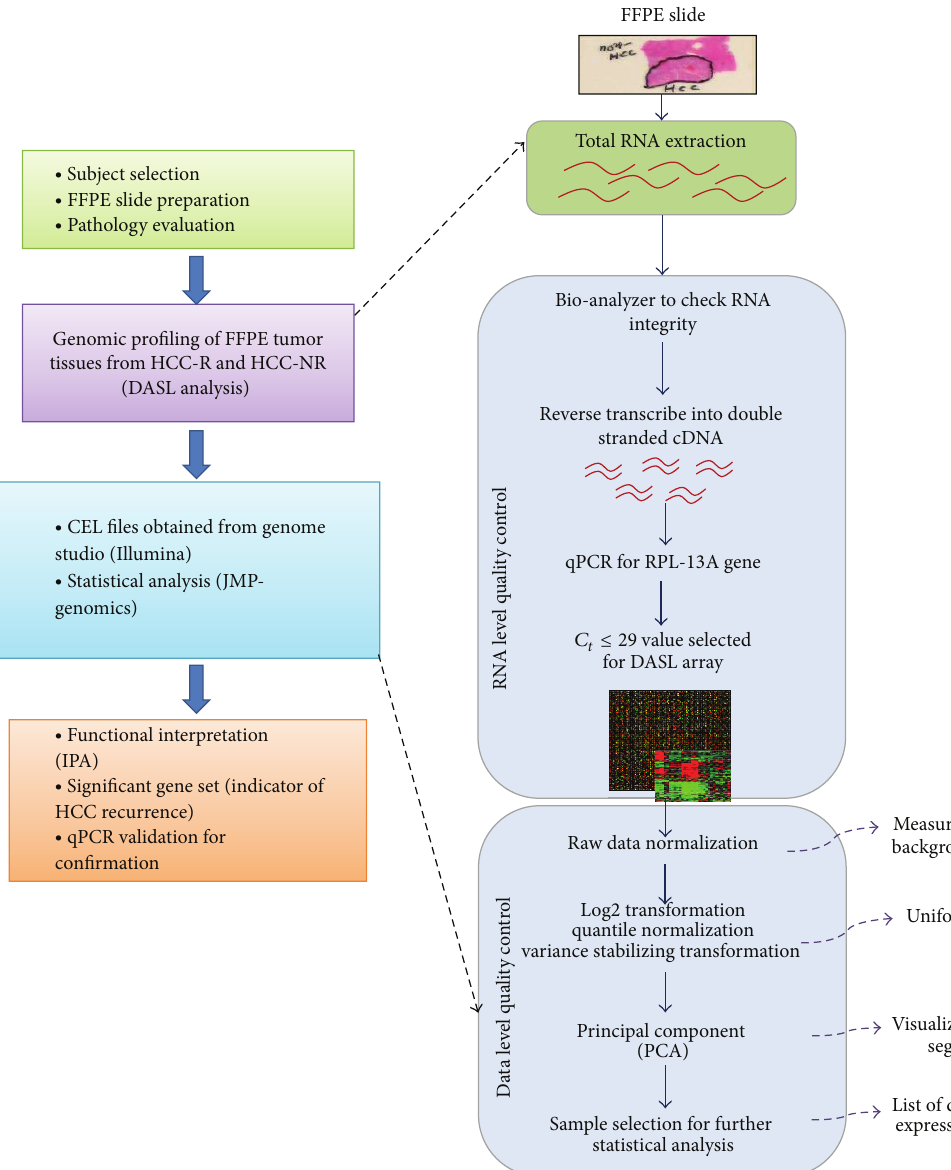
Figure 2: Experimental strategy for comparative transcriptome analysis of HCV-associated HCC with or without recurrence, using FFPE tissue to determine molecular signatures of HCC